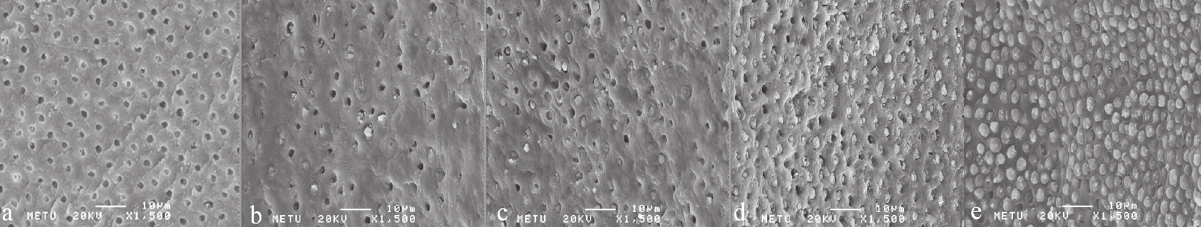
Figure 1- Scanning electron microscopy (SEM) images showing (a) open dentin tubules after EDTA treatment; (b) partially obturated dentin tubules in the apical section using AH Plus; (c) partially obturated dentin tubules in the apical region using the EndoSequence BC sealer; (d) superior sealing in the coronal region using AH Plus; and (e) superior sealing in the coronal region using EndoSequence BC